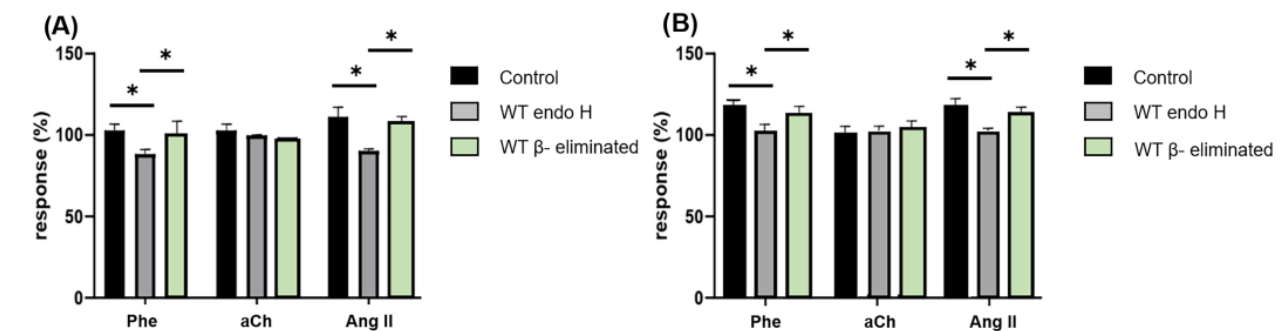
Figure 7. Modification of CPP and LVP in response to agonists when interacting C. albicans without N- linked mannan and C. albicans without O- linked mannan with coronary endothelium. Heart re- sponse, expressed as percentages of ( A ) CPP and ( B ) LVP, when Phe, aCh and Ang II are adminis- tered in the absence (Control) and in the presence of C. albicans without N- linked mannans (WT Endo H) or C. albicans without O- linked mannans (WT β -eliminated). Bars (mean SD) show the result of at least three independent experiments (* p < 0.05).